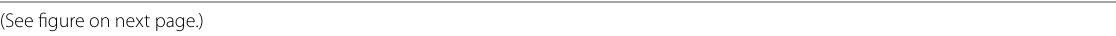
figure on next Fig. 15 Upper teeth of Protadelomys lugdunensis Hartenberger, 1969 from Lissieu (Rhône). a L2627, left M1–M2, Holotype; a1, occlusal view; a2, lingual aspect. b LIS 11, left DP4; b1, occlusal view; b2, lingual aspect; b3, buccal aspect. c : L2629, left P4; c1, occlusal view; c2, lingual aspect; c3, buccal aspect. d LIS 13, right P4, occlusal view. e LIS 10, right P4; e1, occlusal view; e2, lingual aspect; e3, buccal aspect. f LIS 45–2, left P4–M1; f1, occlusal view; f2, buccal aspect of P4; f3, lingual aspect of P4. g L 45–1, left M1; g1, occlusal view; g2, lingual aspect; g3, buccal aspect. h LIS 14, left M1, occlusal view. i : LIS 6, left M1, worn; i1, occlusal view; i2, lingual aspect; i3, buccal aspect. j : LIS 22, right M1, strongly worn; j1, occlusal view; j2, lingual aspect; j3, buccal aspect. Scale bar: 1